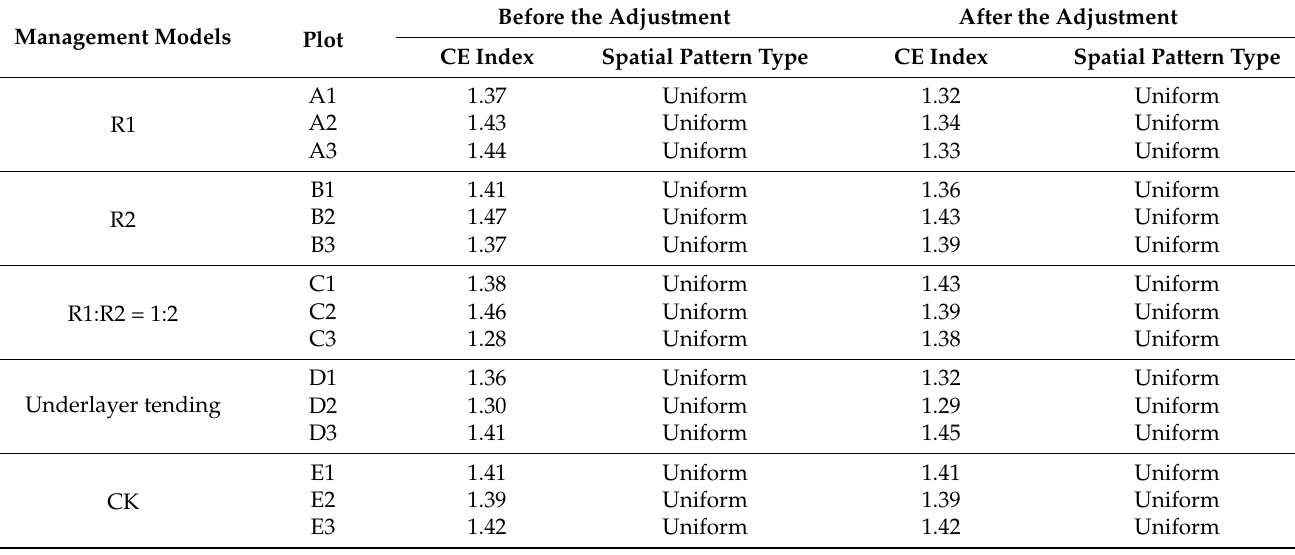
Table 3. Clark and Evans index values and spatial pattern types of stand with different management modes. Management